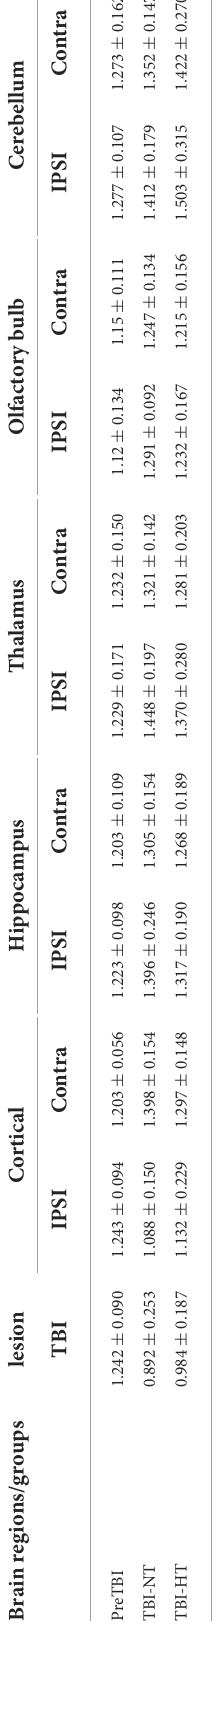
(Figure 8D), whether for the TBI-HT group or TBI-NT group. The quantitative kinetic parameters derived from TICs in Figure 8 are shown in Figure 9. The TBI-HT rats exhibited significantly decreased infusion rate, clearance rate value, and increased clearance time constant value in five